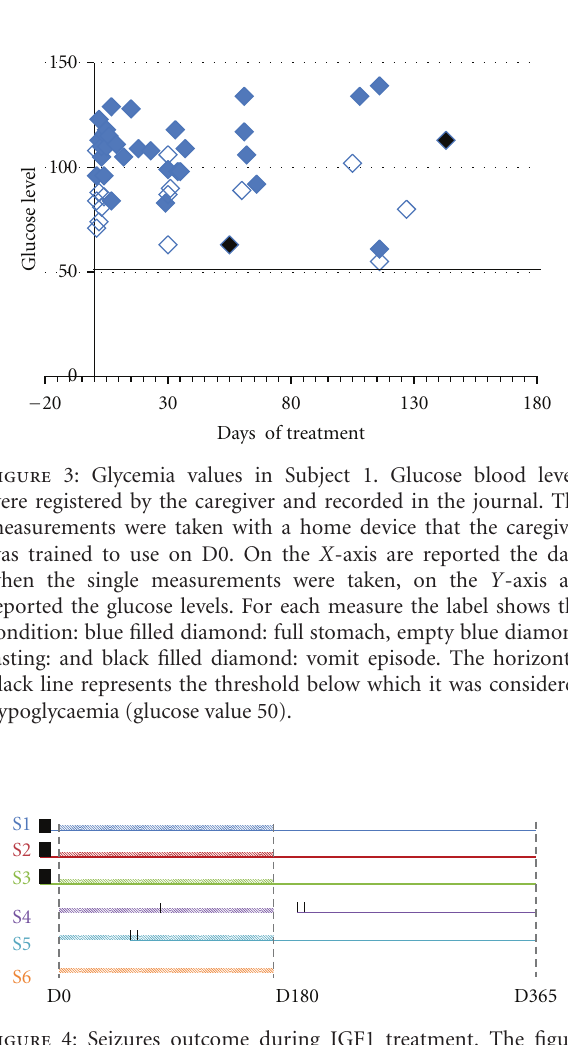
Figure 4: Seizures outcome during IGF1 treatment. The figure shows the outcome of seizures during one year starting with D0. The dotted lines represent the start (D0) and the end (D180) of the treatment. Each patient is color-coded: S1: blue, S2: red, S3: green, S4: purple, S5: cyan, and S6: orange. The black vertical lines represent seizures episodes. The color-coded horizontal straight lines represent the therapy for seizures (valproic acid), while the dashed color-coded lines represent the IGF1 treatment that lasted from D0 to D180. Patients S1, S2, and S3 had seizures before the start of IGF1 treatment, and they were simultaneously treated with valproic acid and IGF1. S6 did not develop seizures. S4 had one single episode of seizures around D90, and the treatment with valproic acid started only after D180, when the seizures become frequent. S5 showed frequent seizures around P90 and the treatment with valproic acid started immediately.